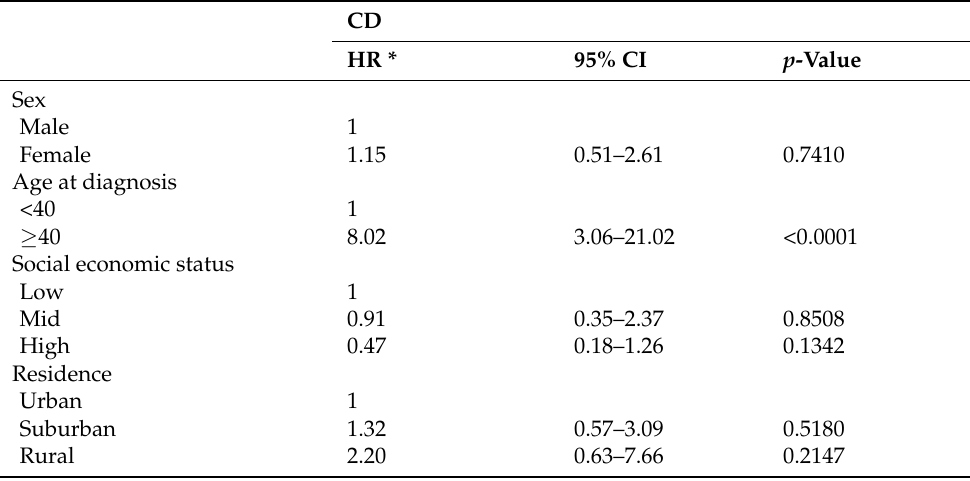
Table 6. Multi-variate analysis of risk factors of CRC in CD